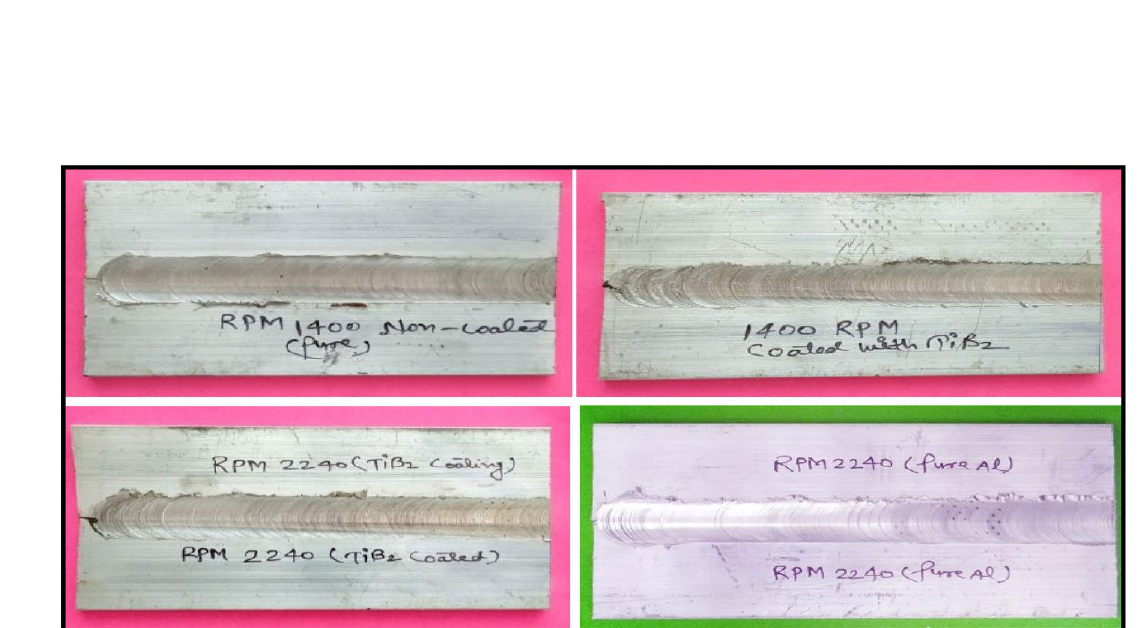
Figure 4. Fabricated joints of all